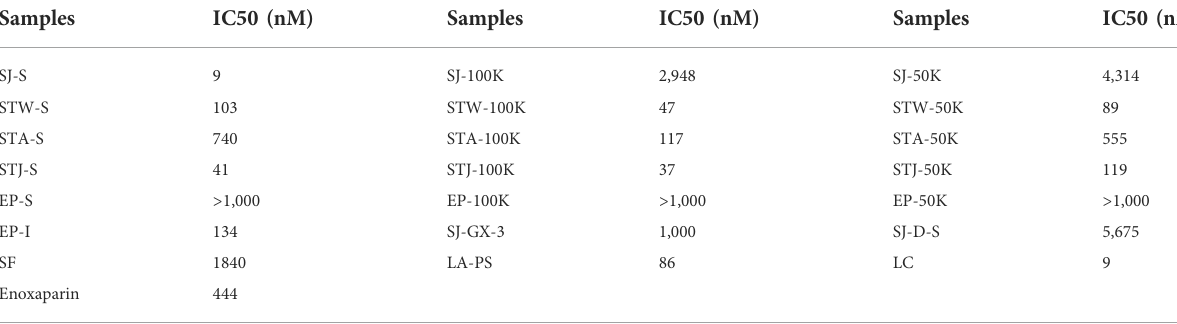
TABLE 2 IC 50 values of sulfated glycans on inhibiting AT binding to heparin (on chip surface). Samples IC50 (nM) Samples IC50 (nM) Samples